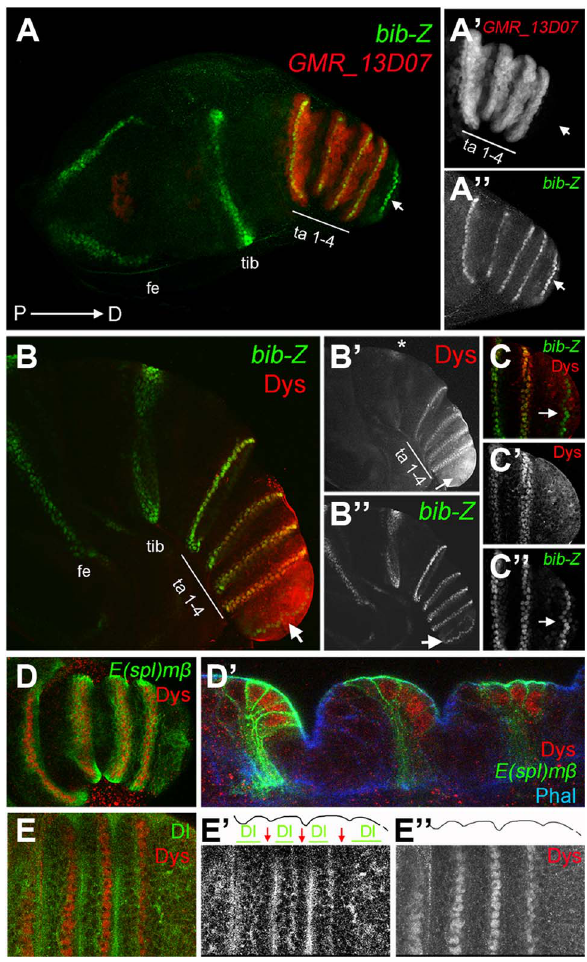
Figure 1. dys is expressed in the presumptive tarsal joints. (A) Activity of the Janelia line GMR_13D07 that drives GFP expression (red) in the presumptive tarsal leg joints. Note that this line is not active in the most distal joint (arrow) or the proximal ones. bib-Z in green marks all the joints. Tarsal segments 1–4 (ta 1–4), tibia (tib) and femur (fe). (A 9 and A 0 ) Single channels for GMR_13D07 and bib-Z , respectively. Distal tip of prepupal leg discs is to the right in all the panels. (B and C) Dys antibody staining (red) and bib-Z (green) expression in a prepupa leg disc. (C) Close view of the tip of the leg. Single channels for Dys (B 9 and C 9 ) and bib-Z (B 0 and C 0 ). Note that dys is expressed in the presumptive tarsal joints 1 to 4 (ta 1–4) and in an incomplete ring in the tibial/tarsal joint (asterisk), and that Dys is not expressed in the tarsal/pretarsal joint (arrow). (D) Dys (red) co-localize with E(spl)m b -CD2 (green) in the tarsal joints. (D 9 ) Sagittal view of a prepupal leg disc epithelium stained with Phallodin (Phal) (blue), E(spl)m b -CD2 (green) and Dys (red). The joints between tarsal segments 1/2, 2/3 and 3/4 are shown. (E) Dys (red) is localized distal and adjacent to Dl domains (green) in the tarsal segments 1 to 4. Single channels for Dl (E 9 ) and Dys (E 0 ) are shown. The row of dys -expressing cells is marked with red arrows, while Dl domains are indicated with green bars in E 9 . Outlined of the leg is drawn in E 9 and E 0 . doi:10.1371/journal.pgen.1004621.g001 (Figure 2A, 2B and Figure S2A and S2B). In addition we detected the loss of the joint between the a5 and the arista in the antenna (Figure 2D and 2E). We also expressed a dys -RNAi construct that efficiently reduced Dys protein levels (Figure S2C). dys knockdown in the Dll domain ( Dll-Gal4 /UAS- dys -RNAi; distal tibia to claw)